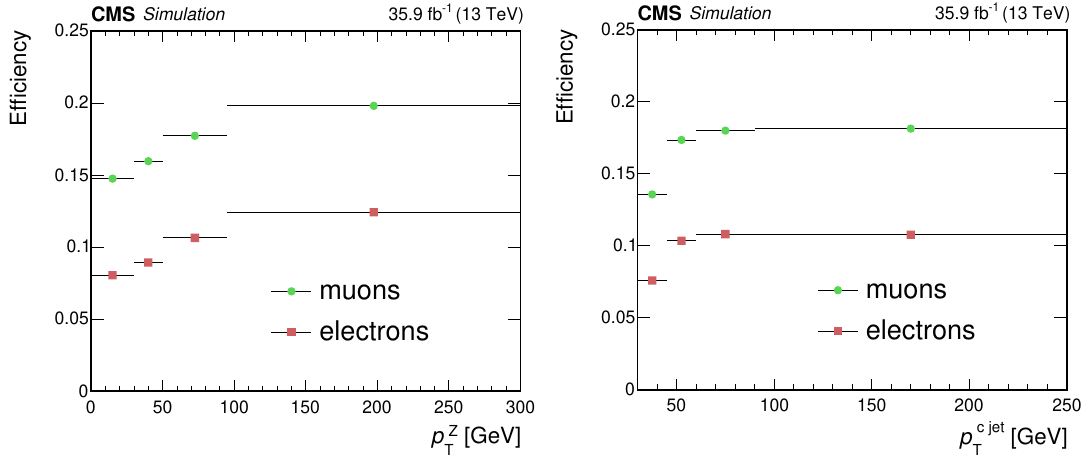
. The plots show distributions for the electron and muon T (left) and p c jet T T